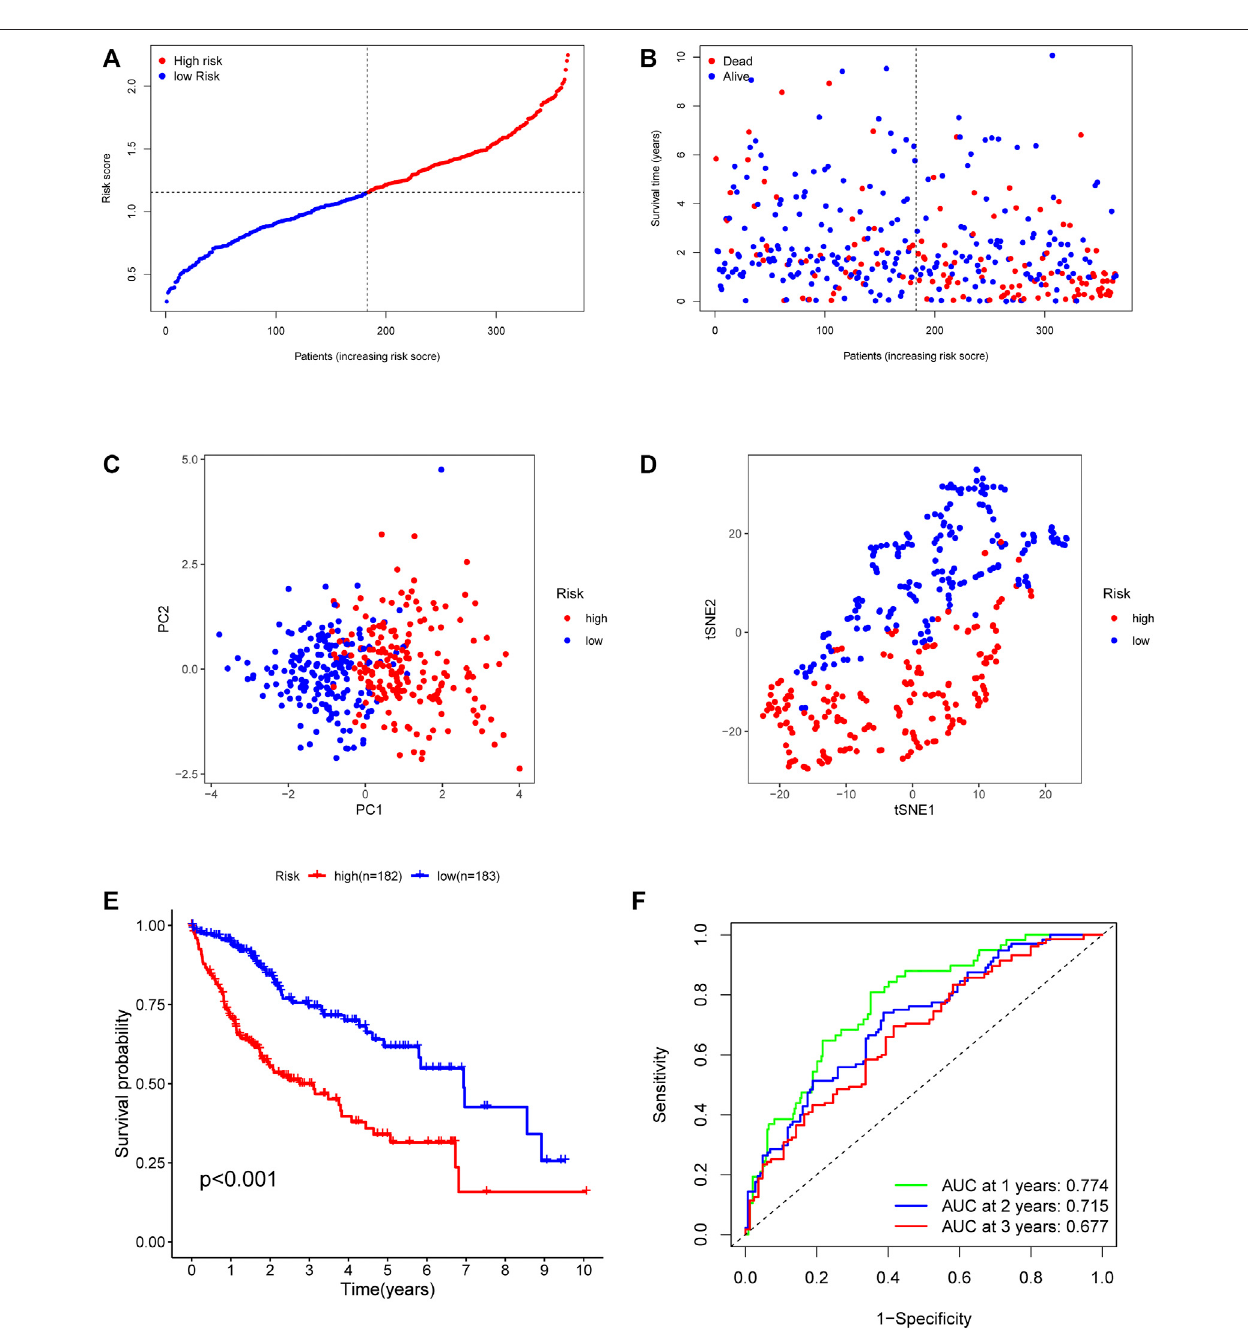
FIGURE 4 | Prognostic value of the fi ve-gene risk model in the TCGA cohort. (A) The median value of risk scores with survival and statuses of HCC patients depends on the fi ve-gene risk model in the TCGA cohort. (B) The distribution of risk scores with survival and statuses of HCC patients depends on the fi ve-gene risk model in the TCGA cohort. (C) Principal component analysis of HCC patients in the TCGA cohort. (D) t-SNE analysis of HCC patients in the TCGA cohort. (E) Survival analysis of patients in the high-risk group and low-risk group based on the prediction risk score formula. (F) One-, two-, and three-year ROC curves of the bene fi t model for assessing the prognostic performance of the gene signature in the TCGA